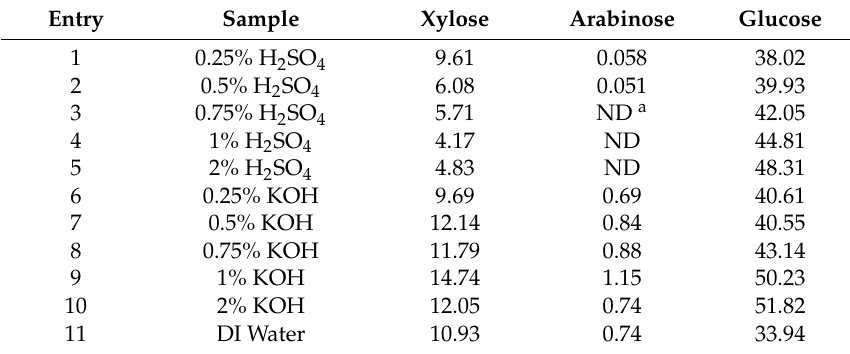
Table 2. Major sugar composition of bamboo residues